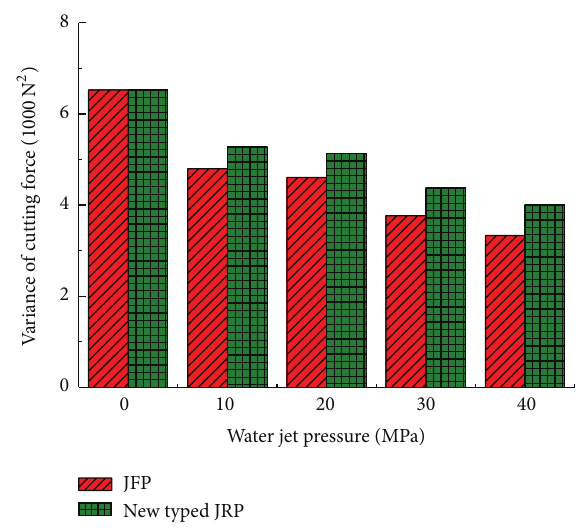
Figure 13: Variance of the cutting force for later